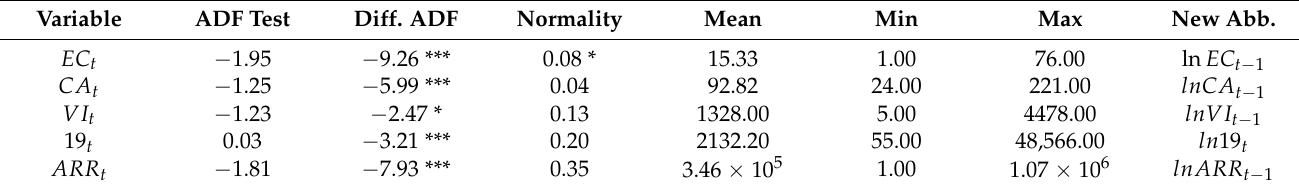
Table 3. Mis-specification tests and descriptives of summary statistics.